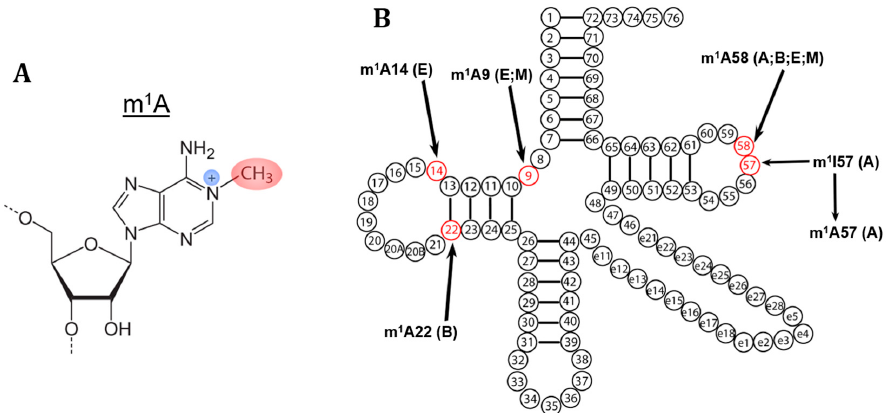
Figure 1. m 1 A modifications in tRNAs. ( A ) Chemical structure of the m 1 A modification on